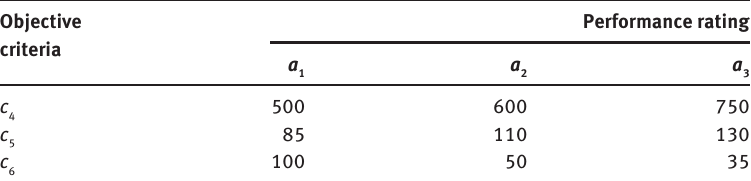
Table 2: The Performance Ratings for Three Alternatives under Each Objective Criterion. Objective criteria